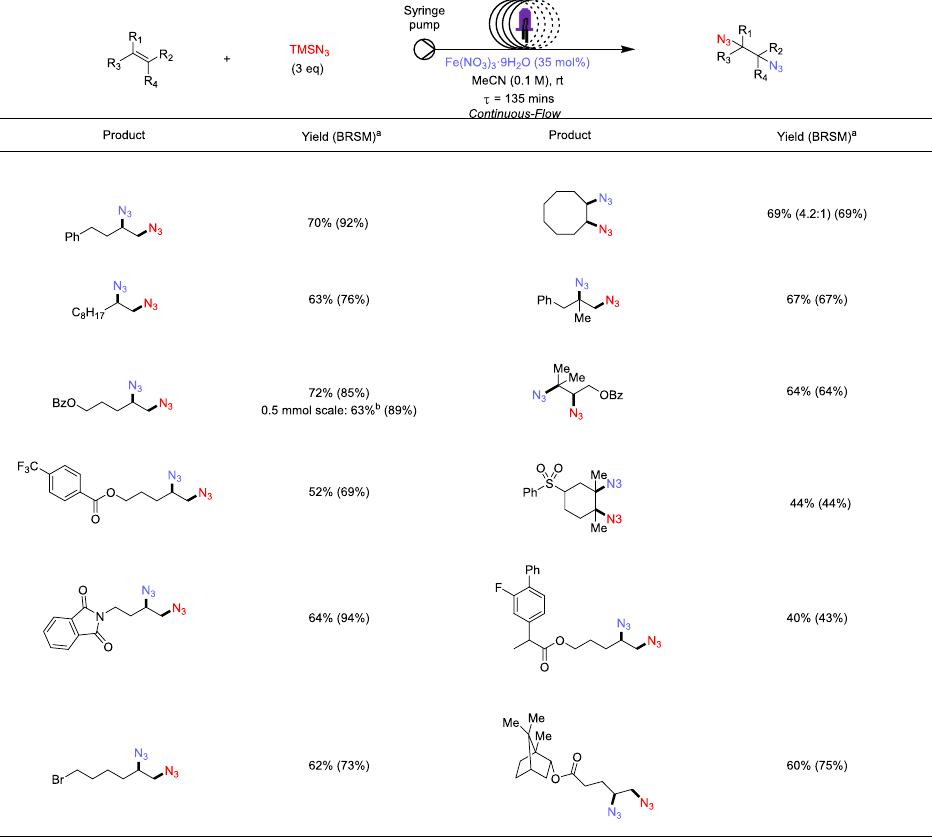
Fig.4|Scopeofdiazidationofalkenes( fl owreaction). Reactionconditions:alkenes(0.1mmol,1equiv.),TMSN 3 (3equiv.),Fe(NO 3 ) 3· 9H 2 O(35mol%),MeCN(0.1M),24h, RT, under air, 2×390nm Kessil blue LED